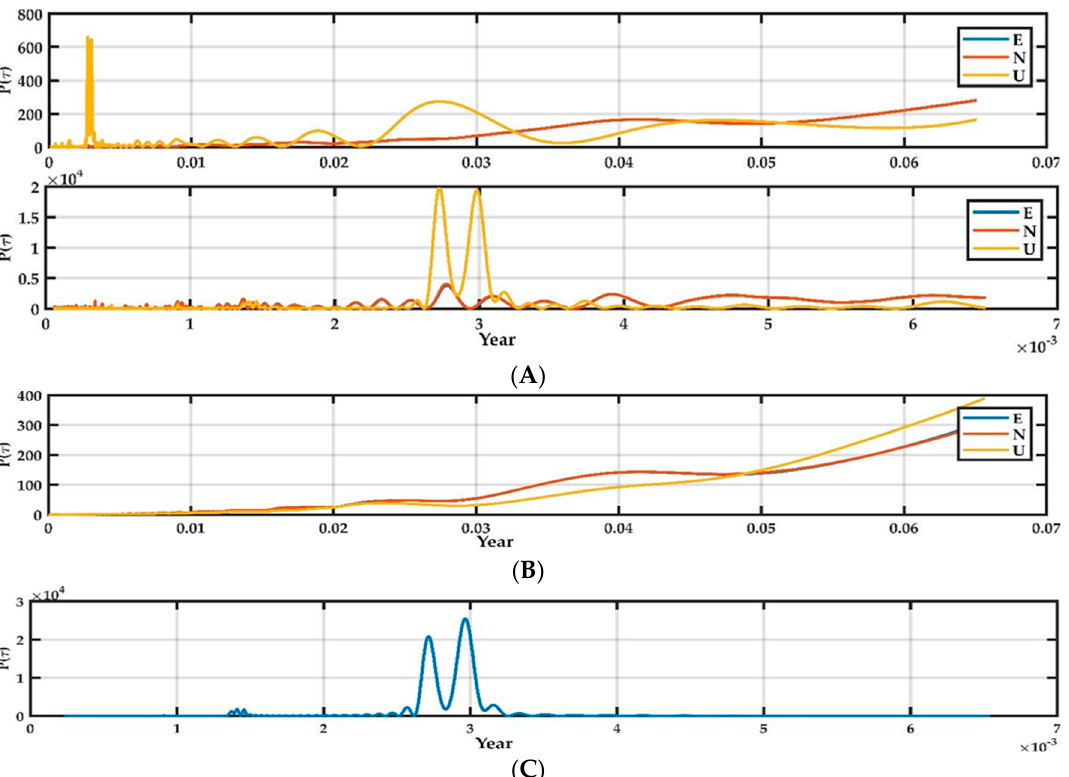
Figure 5. Motion across the ice flow direction at point DRY1.